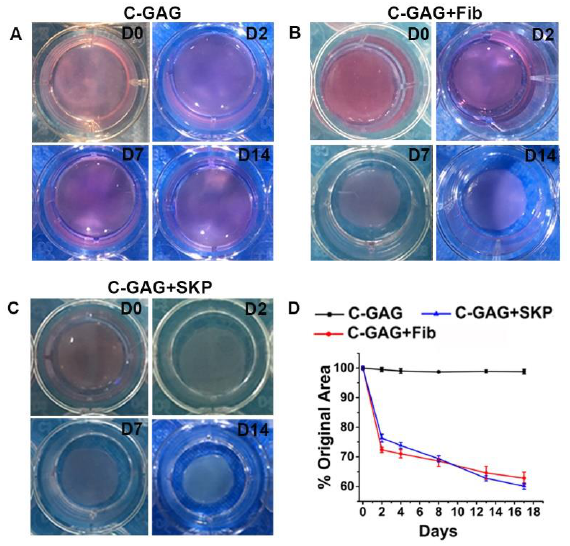
Figure 3. SKP-mediated C-GAG matrix contraction. ( A – C ) Digital photographs of SKPs-populated C-GAG matrixes were taken at 0, 2, 7 and 14 days of incubation. ( A ) Matrix without cells (control). ( B ) Matrix with fibroblasts. ( C ) Matrix with SKPs. ( D ) Quantification of the matrix contractions using NIH Image J. The values represent the mean ± SD ( n = 3).